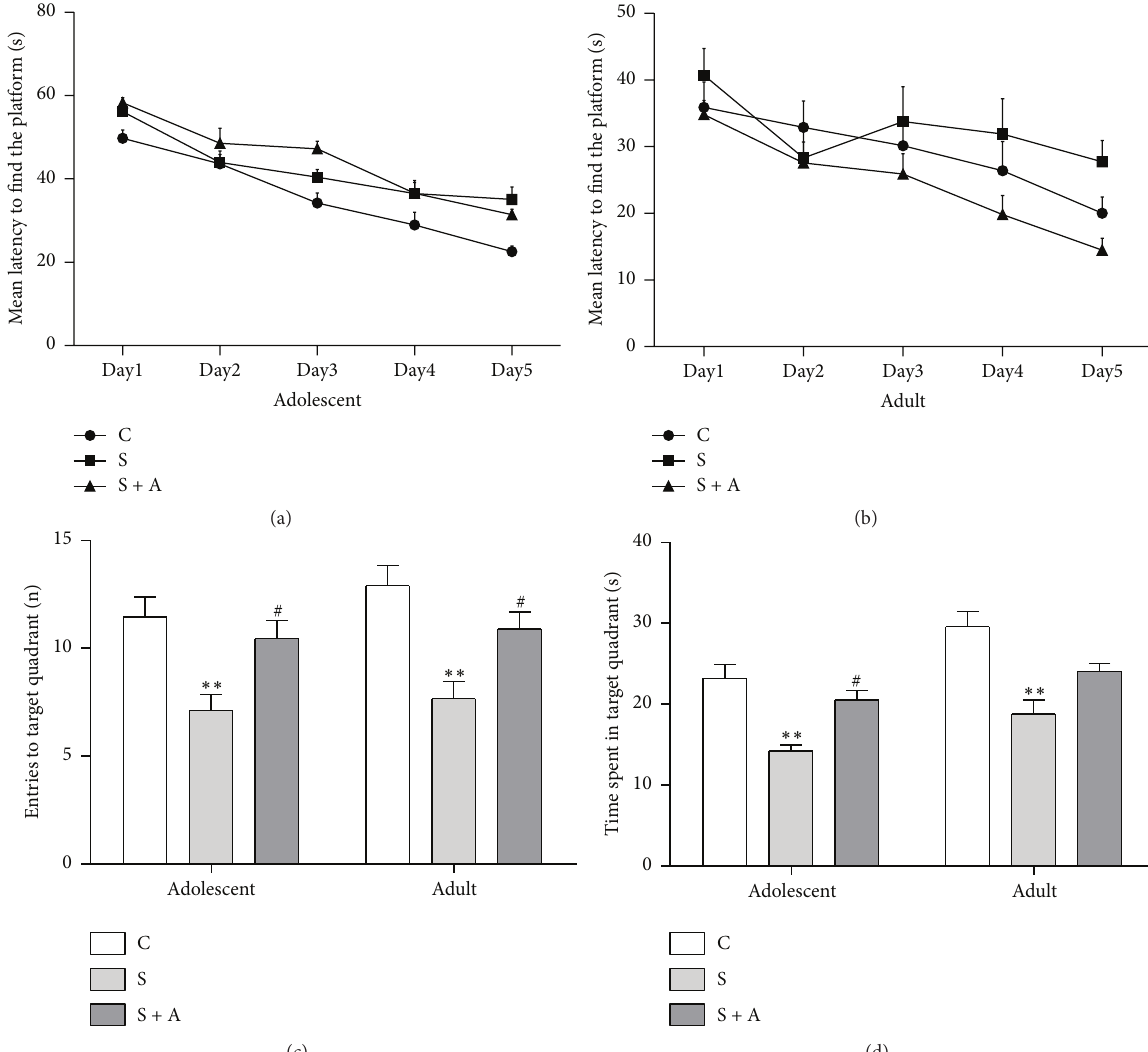
Figure 3: Spatial memory performance in the Morris water maze ( 𝑛 = 8 in each group). (a) Mean escape latency to the platform in the Morris water maze in adolescence. (b) Mean escape latency to the platform in the Morris water maze in adulthood. (c) Entries to the target quadrant in adolescence and adulthood. (d) Time spent in the target quadrant in adolescence and adulthood. Values were expressed as mean ± SEM. ∗∗ indicates 𝑝 < 0.01 versus CON; # indicates 𝑝 < 0.05 versus